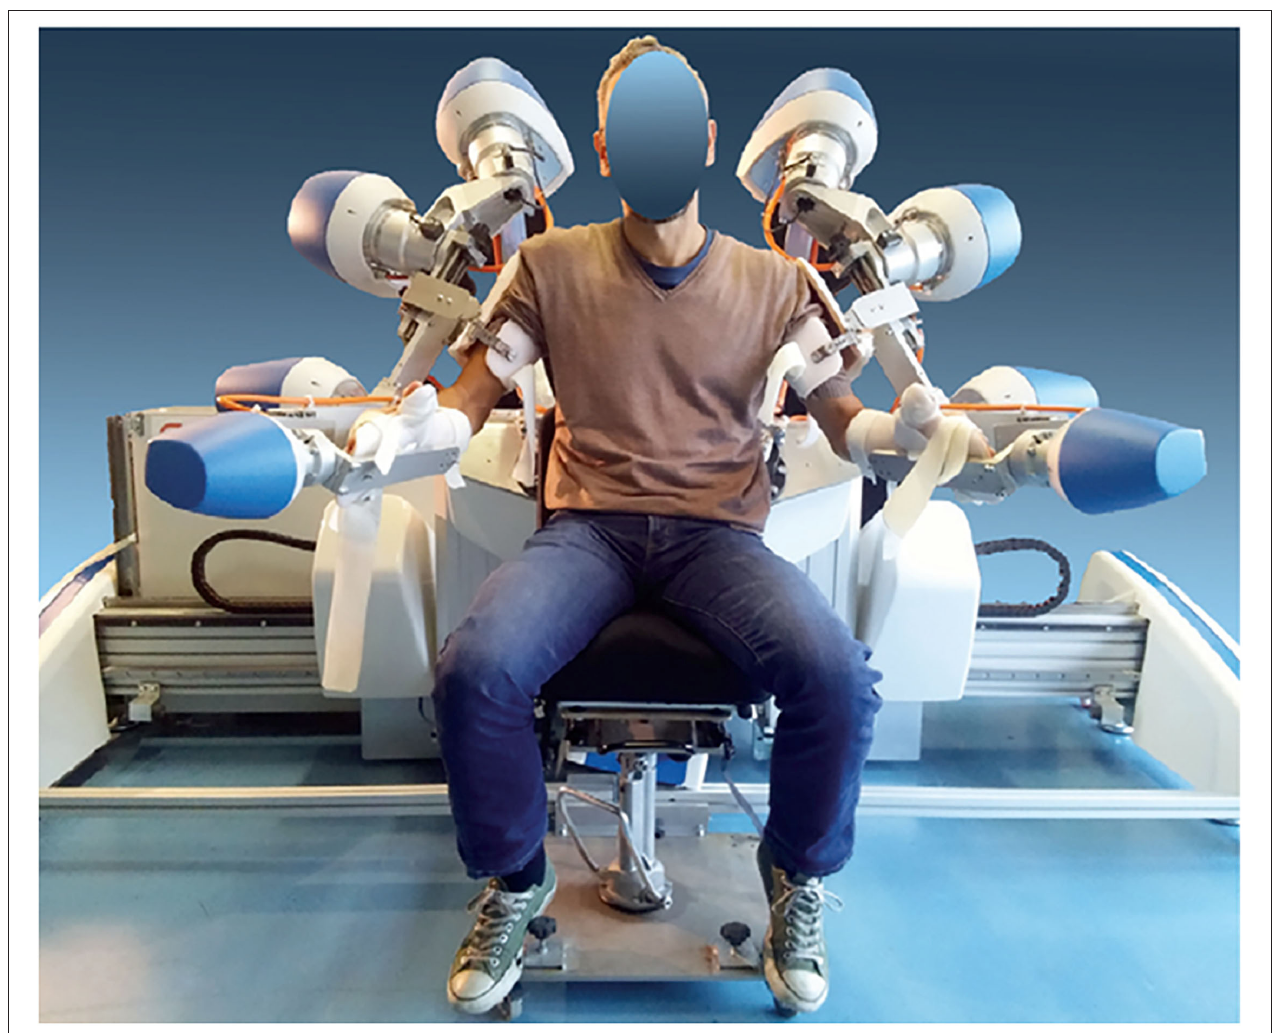
FIGURE 1 | Integrated Robotic System for Stroke (IRSS) prototype Automatic Recovery Arm Motility Integrated System (ARAMIS) [reproduced with permission from Pignolo et al. ( 25)].